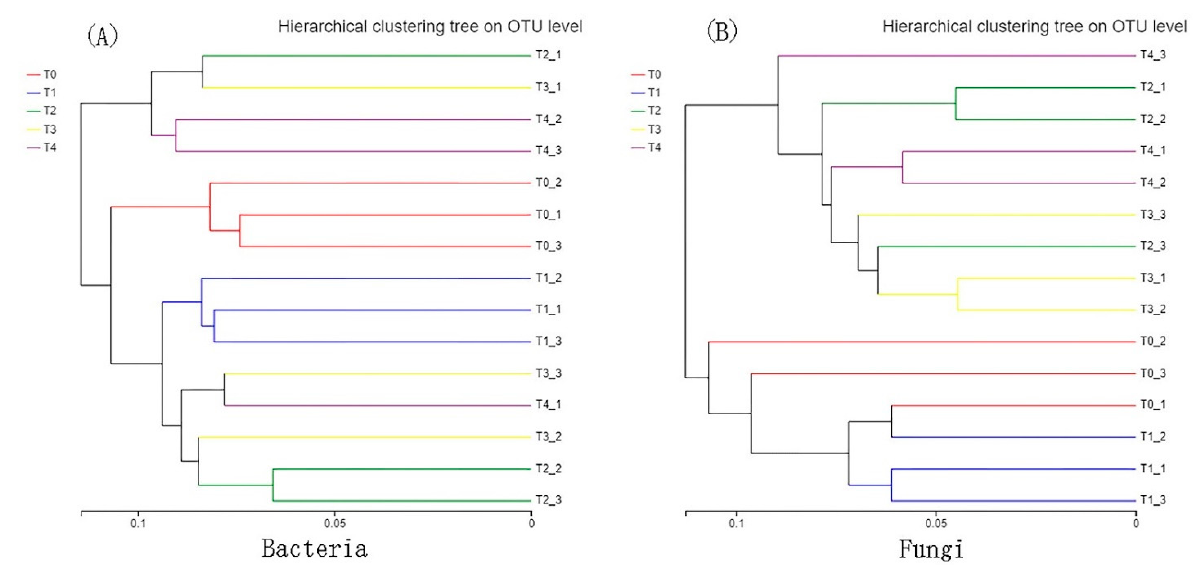
Figure 2. Hierarchical cluster analysis among different treatments. The lengths between branches represent the distances between the samples, and different groups are presented in different colors; when the stacked column chart is displayed, the composition of the dominant species in each sample is displayed on the right side of the clustering tree; the stacked column chart is not displayed by default. ( A ) Hierarchical cluster analysis of bacteria, ( B ) Hierarchical cluster analysis of